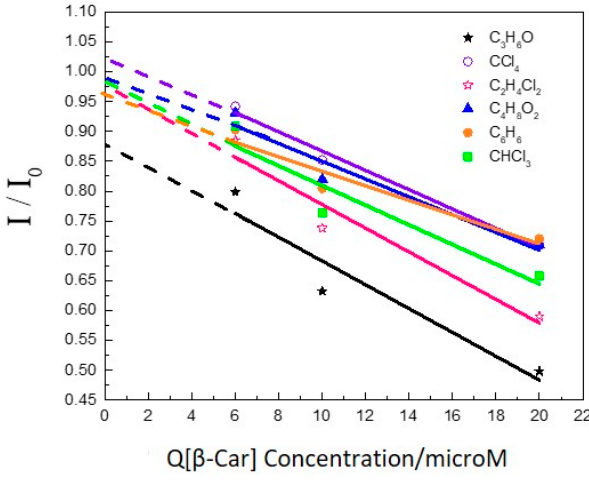
Figure 2. Stern-Volmer type plot of Chl-a and β -Car mixing in different solvents.